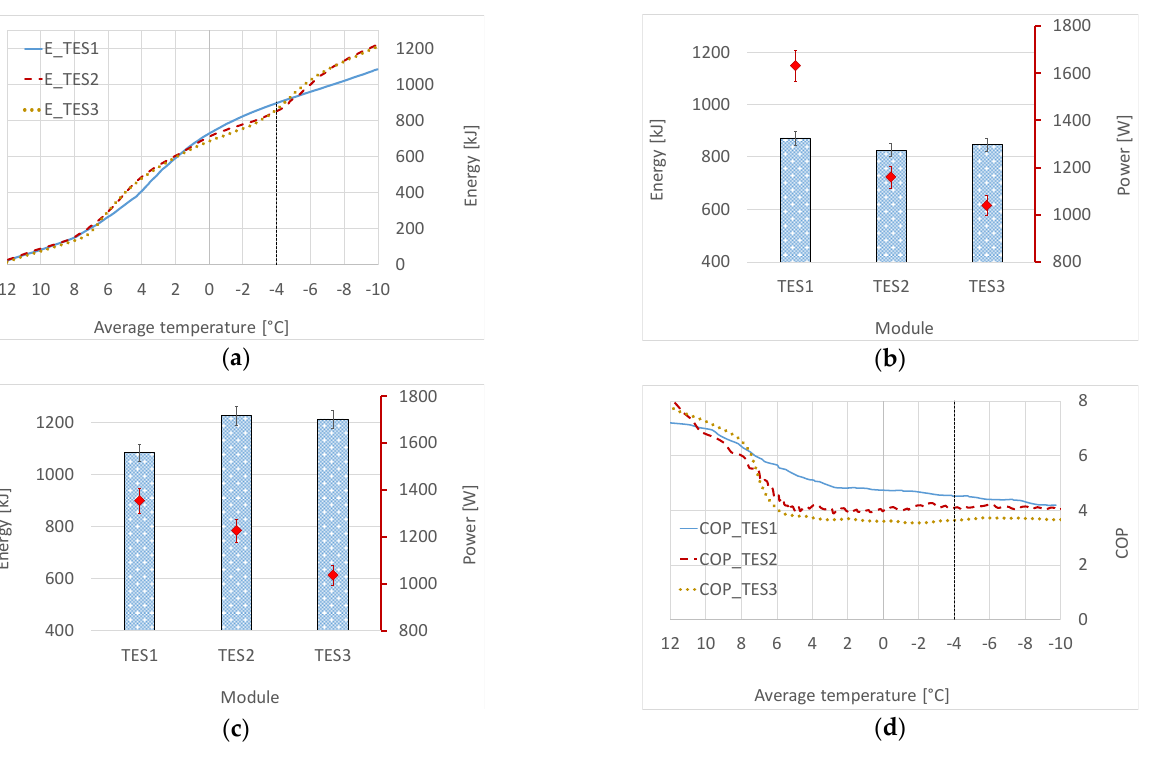
( d ) Figure 4. Temperature profiles of the charging process for ( a ) TES (cid:2869) , ( b ) TES (cid:2870) , ( c ) TES (cid:2871) , and ( d ) po- sition of temperature sensors. 3.3. Energy Storage, Power, and COP during the Charging Process Figure 5 summarizes the results obtained during the charging process based on en- ergy, average power, and the COP of the system. Figure 5a presents the energy stored as the module charges from 12 °C to lower temperature values. It is observed that at an av- erage temperature of − 4 °C, TES (cid:2869) had stored the highest amount of energy despite con- taining the minimum amount of PCM due to the high stratification effect in TES (cid:2870) and TES (cid:2871) (seen in Figure 4). TES (cid:2869) shows the highest potential when operating at a narrow temperature range, which is evident in Figure 5a,b, due to its ability to charge the PCM homogeneously. To fully utilize the potential of the PCM (latent energy storage) in TES (cid:2870) and TES (cid:2871) , it is evident in Figure 5b,c that the module should be charged to lower temper-